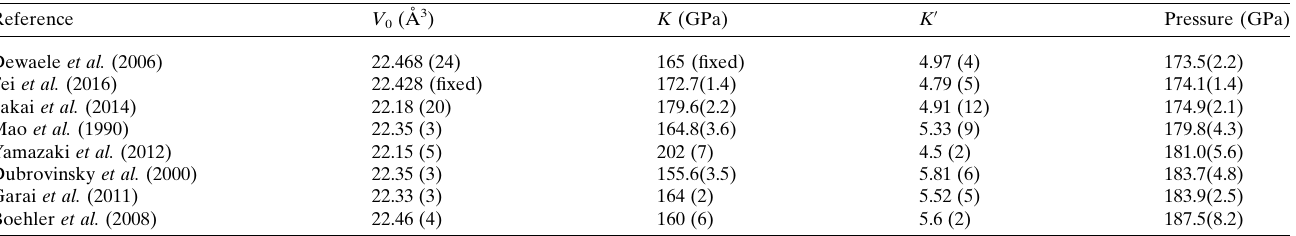
Table 2 Pressures for FeN 4 synthesis based on different 3rd order Birch–Murnaghan EoS’s of hcp -Fe reported in the literature [ V Fe = 15.171 (5) A˚ 3 /unit cell]. Reference